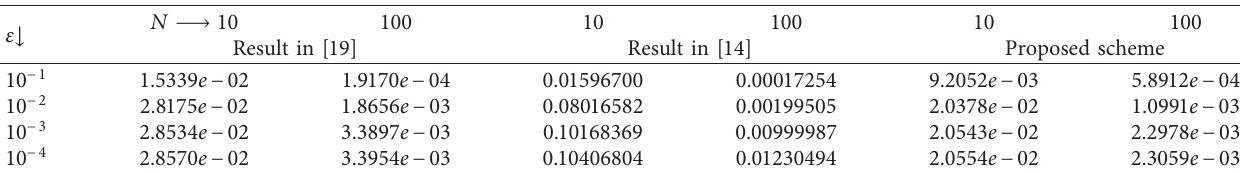
Table 10: Example 4: comparison of maximum absolute error of proposed scheme and results in [14, 19] for δ � 0 . 6 ε and η � 0 . 5 ε